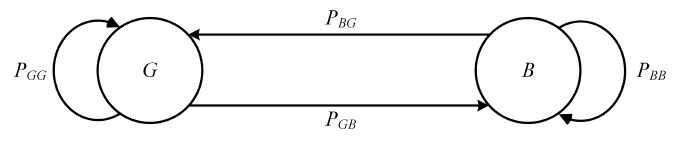
Figure 1. State diagram of the Markov-Gaussian